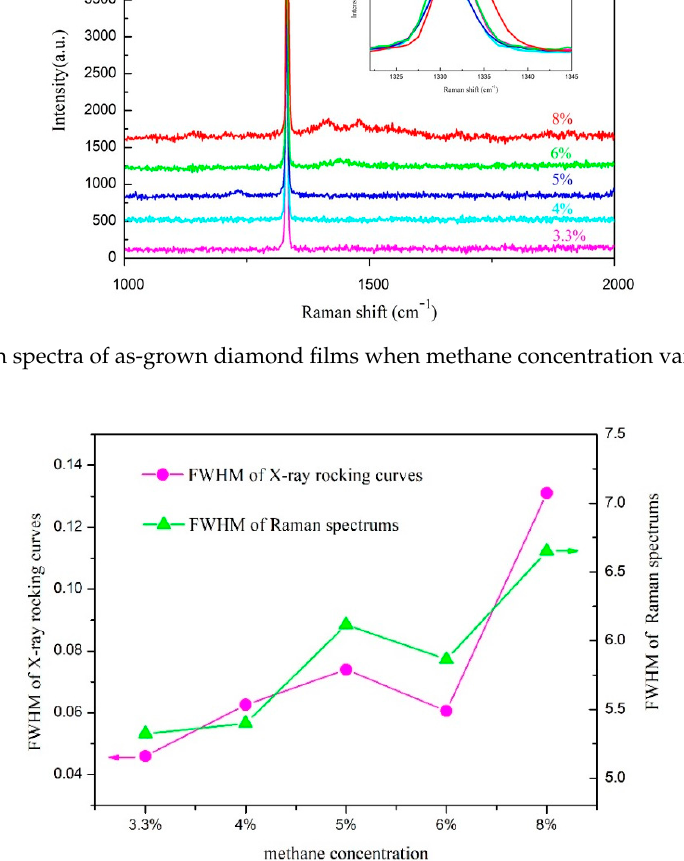
Figure 8. FTIR of the deposited CVD film and HPHT diamond substrate.